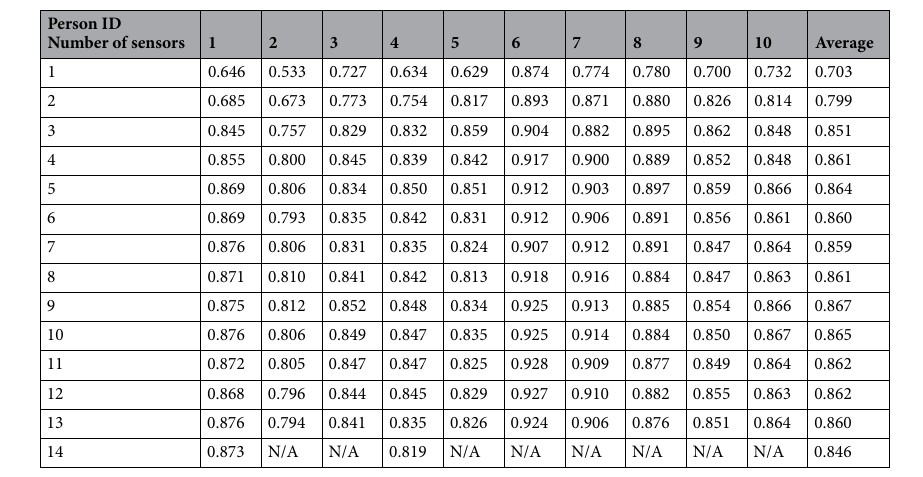
Table 8. Emotion estimation accuracy versus the number of types of sensors.